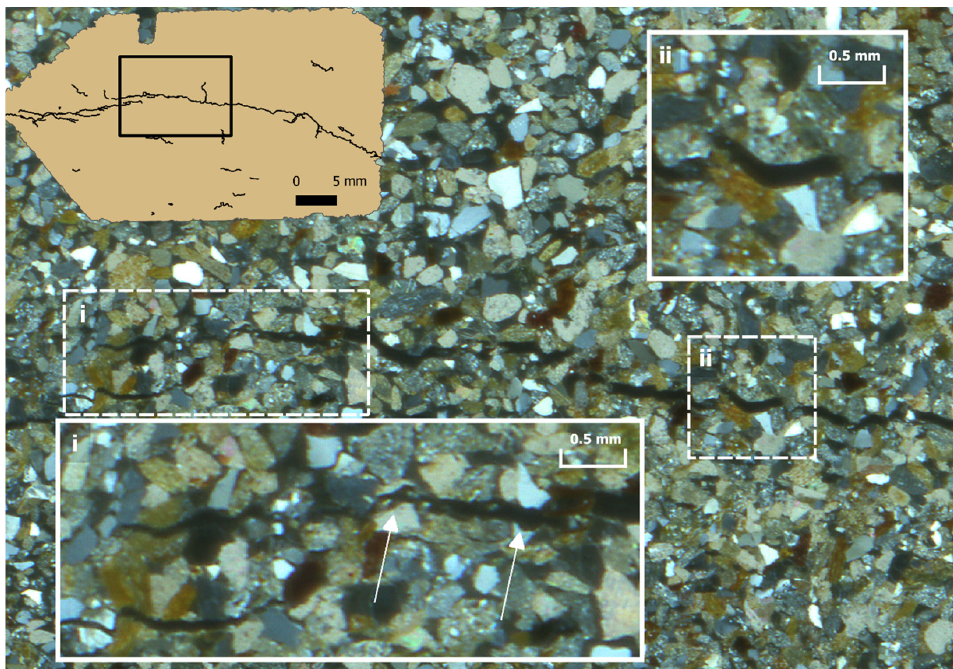
Figure 4. Thin section micrograph under cross polarised light of Sample HS_RF_1P showing the path of radially oriented fracture. The fracture path is both circum- and intragranular as seen in inset ( i ) and ( ii ) respectively. White arrows indicate intragranular fracturing. Note the fractures cutting across clay minerals at a high angle to cleavage in the lower left of ( i ), as well as the zone of overlap between the shorter fracture strands that make up the macro-scale radial fracture.